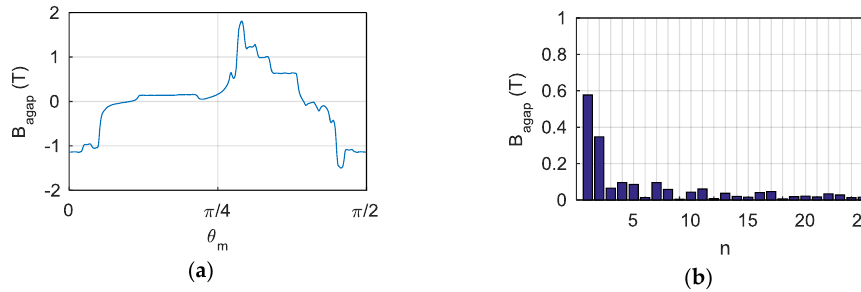
Figure 18. Air-gap flux density ( B agap ) ( a ) waveform; ( b ) harmonic spectrum; for the p = 4, Q s = 12 and n l,w,s = 2 machine.